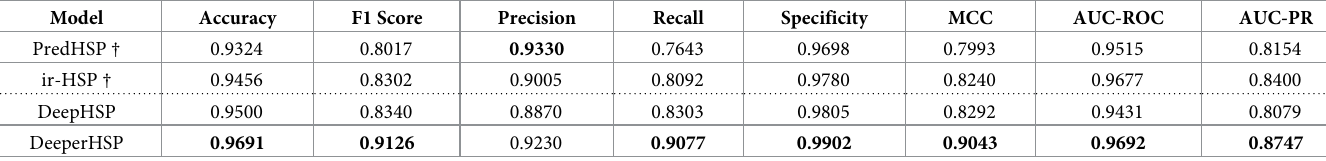
Table 6. Comparison of overall classification performance using independent test.